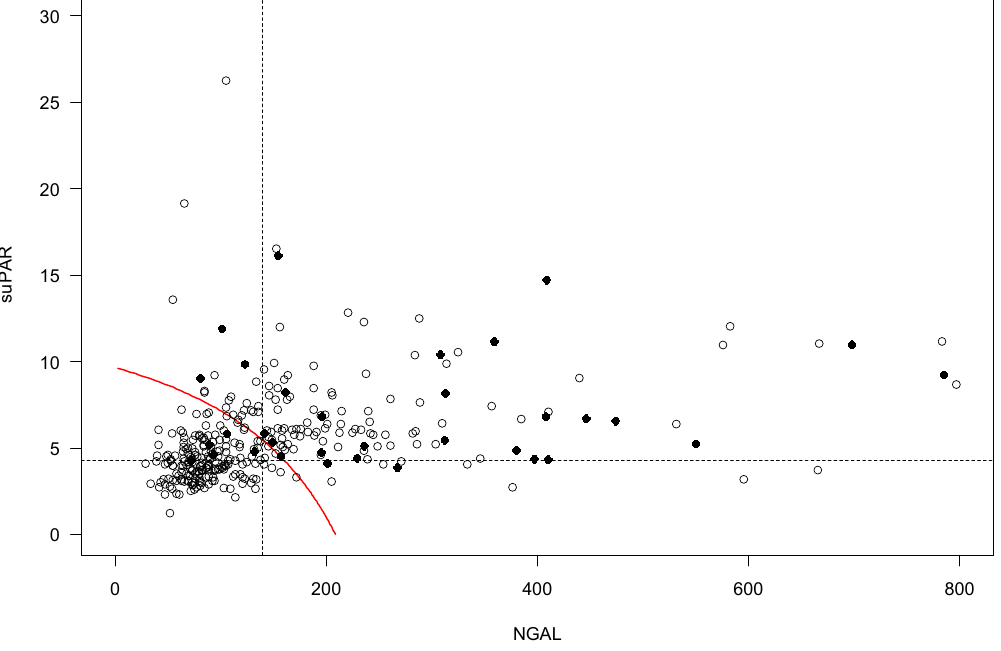
Figure 3. Two-biomarker cut-off approach with suPAR and NGAL (two-variable interaction). The dotted lines represent the cut-off values for NGAL and suPAR set to 139.5 ng/L and 4.26 ng/L, respectively. The red curve illustrates cut-off values for the combinations of suPAR and NGAL.